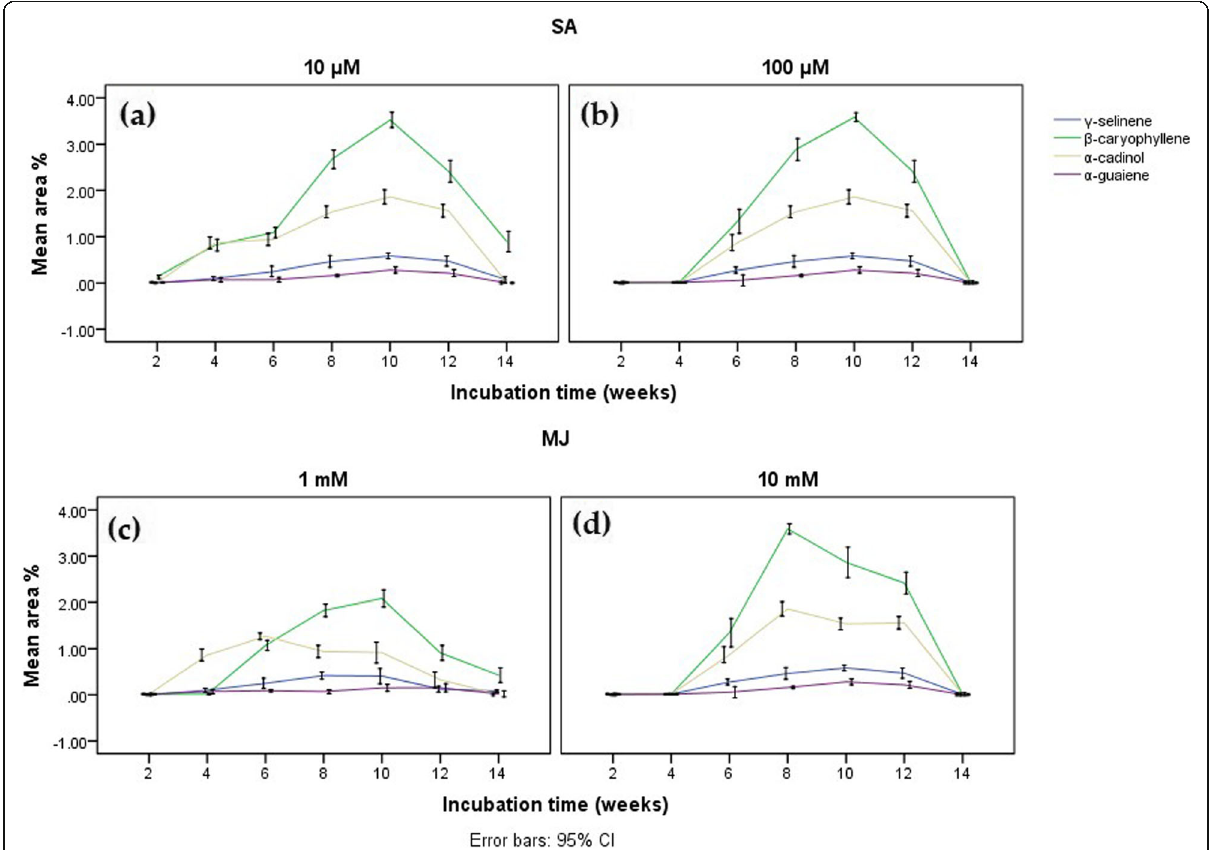
Fig. 2 Mean area percentages of sesquiterpenes produced in G. walla calli under ( a ) 10 μ M SA, ( b ) 100 μ M SA, ( c ) 1mM MJ and ( d ) 10mM